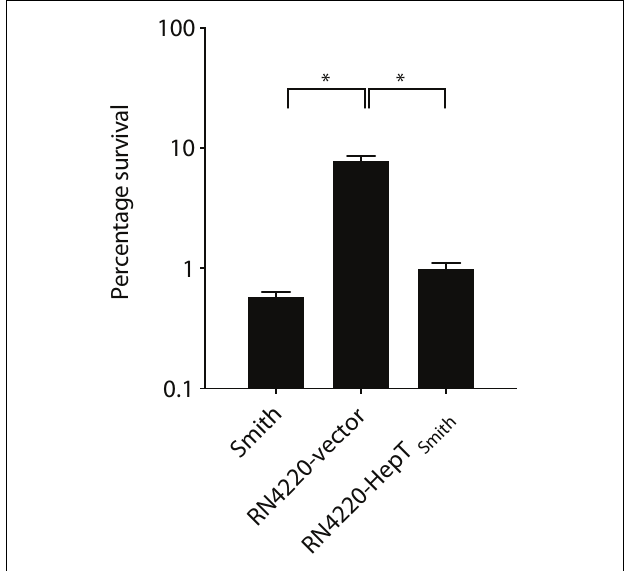
FIGURE 6 | Survival of S. aureus in the presence of lysocin E. Exponentially growing bacteria were treated with 1 mg/L of lysocin E for 30 min, and the colony-forming units were counted. Triplicate data are represented as mean ± SEM. Statistical analysis was performed by one-way ANOVA using Dunnett’s multiple comparison test in GraphPad Prism, and the asterisk indicates a p -value of <